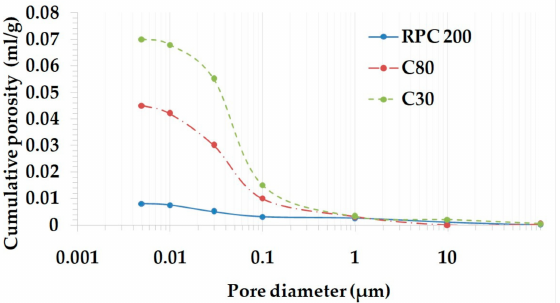
Figure 1. MIP cumulative porosity curves showing the curve corresponding to the reactive powder concrete in comparison with two curves for the C30 and C80 concretes. Table 4. Durability of the reactive powder concrete compared with normal and high strength concrete [3–9].